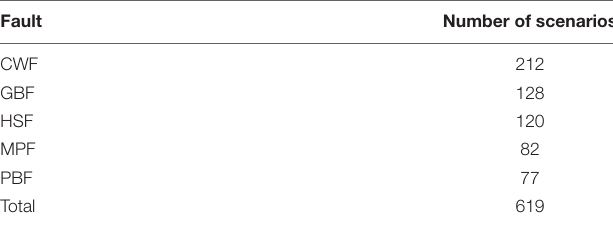
TABLE 4 | Number of considered scenarios in each